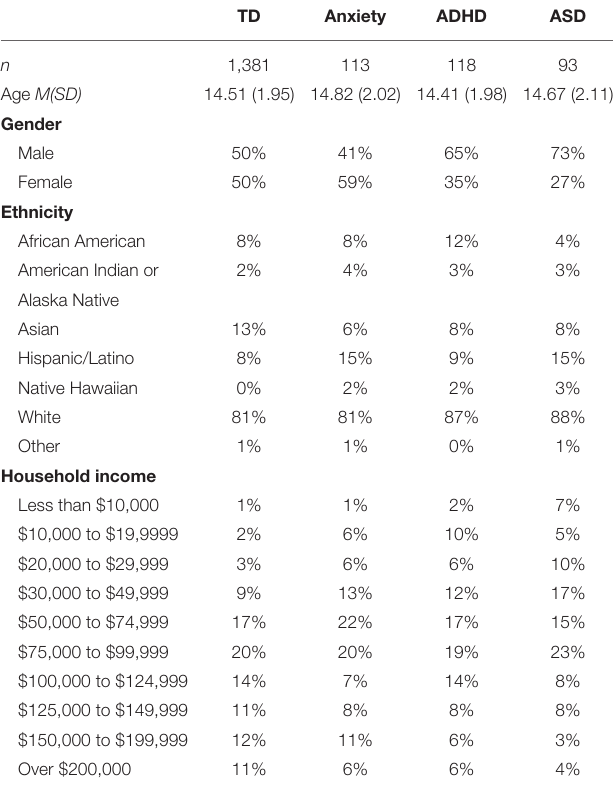
TABLE 1 | Demographic information of